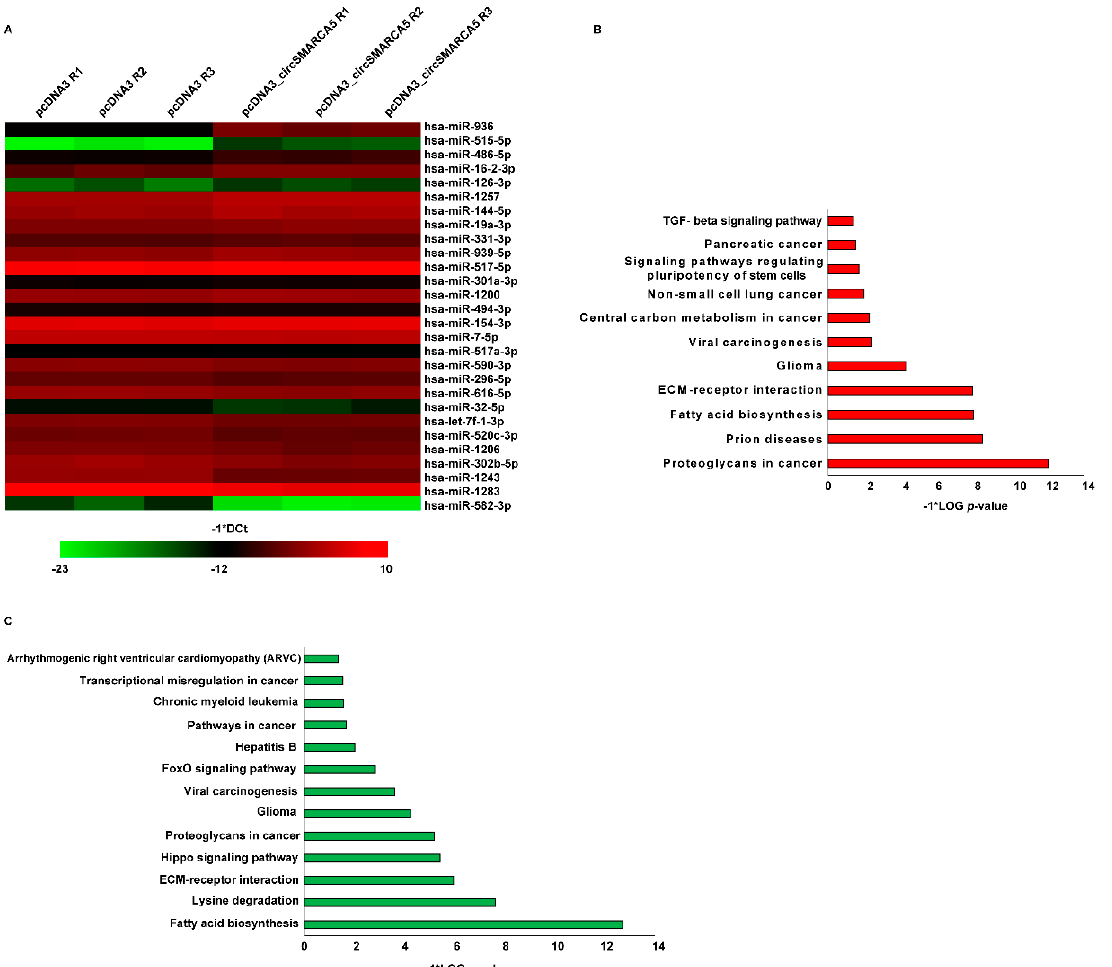
Figure 1. ( A ) Heatmap representation of the expression level of significant DE miRNAs in U87MG transfected for 24 h with the empty plasmid vector (pcDNA3) or with the plasmid vector expressing circSMARCA5 (pcDNA3_circSMARCA5). Data are represented as − 1*DCt (the less its value, the less the expression of DE miRNAs; the higher its value, the higher the expression of DE miRNAs) for the three replicates (R1, R2, R3) of each experimental condition. ( B , C ) Enriched pathways (EPs) controlled by upregulated ( B ) and downregulated ( C ) miRNAs. Only significant ( − 1*LOG p -value ≥ 1.3) EPs are reported in the